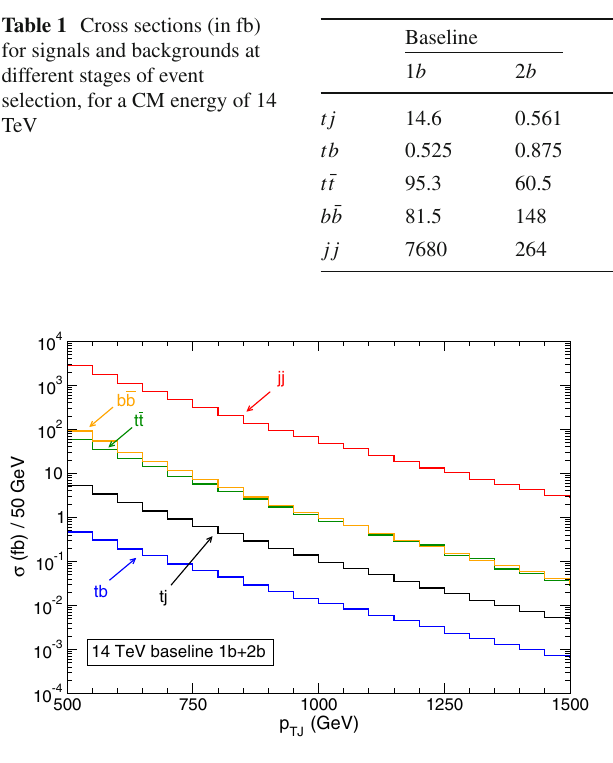
Fig. 1 Signal and background cross sections as a function of the trans- verse momentum of the ‘top’ jet p T J for a CM energy of 14 TeV, with the baseline event selection